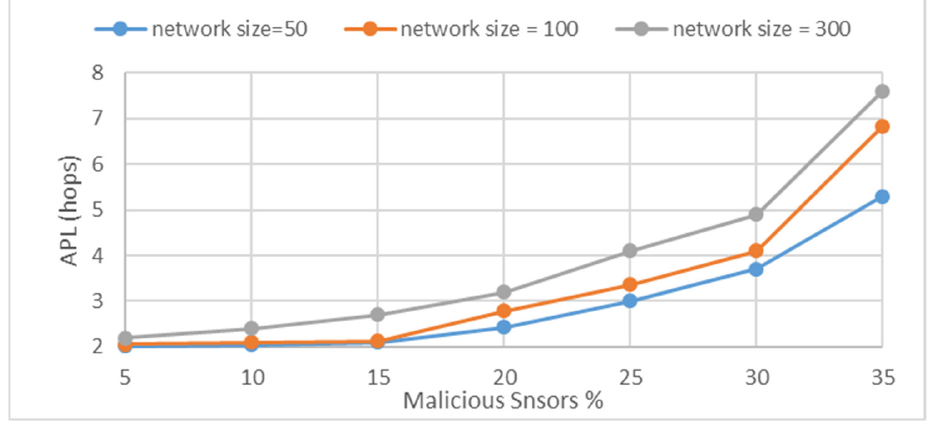
Figure 5. APL vs. % malicious sensors in WSNs.